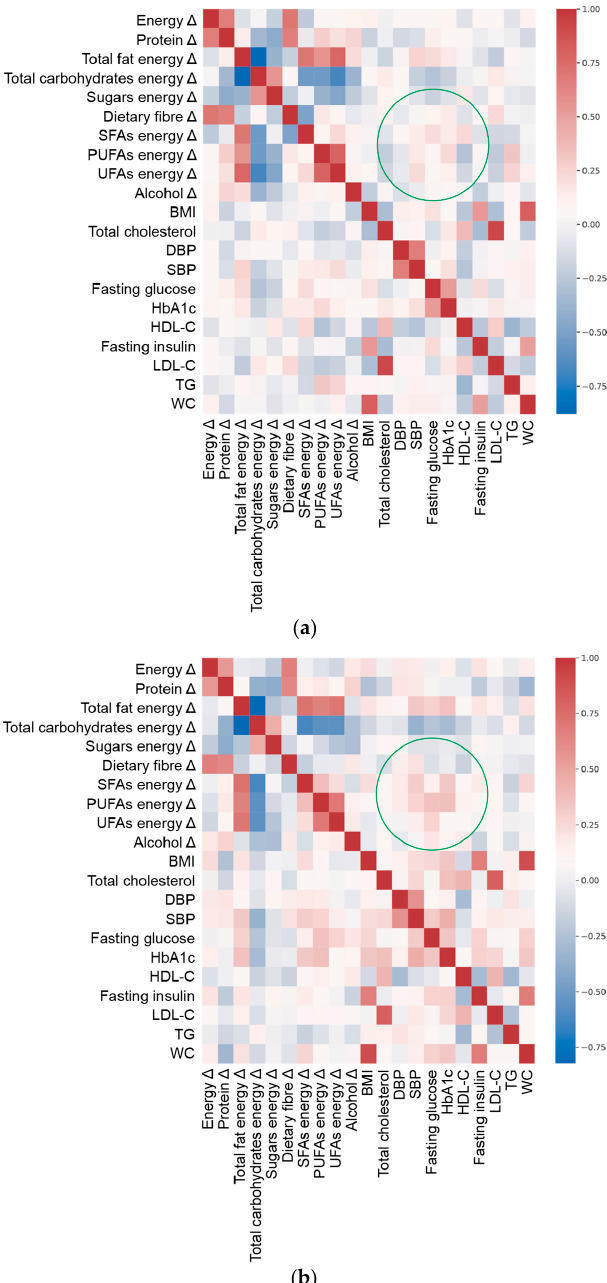
Figure 1. Spearman’s correlation heat map of adequacy of energy/macronutrient intake ( Δ , delta value calculated as difference between current intake and corresponding recommended intake of each variable) and clinical parameters at enrolment (Table 1) in ( a ) females and ( b ) males. Green circle marks an example of a different pattern in correlation between variables and targets in males and females.